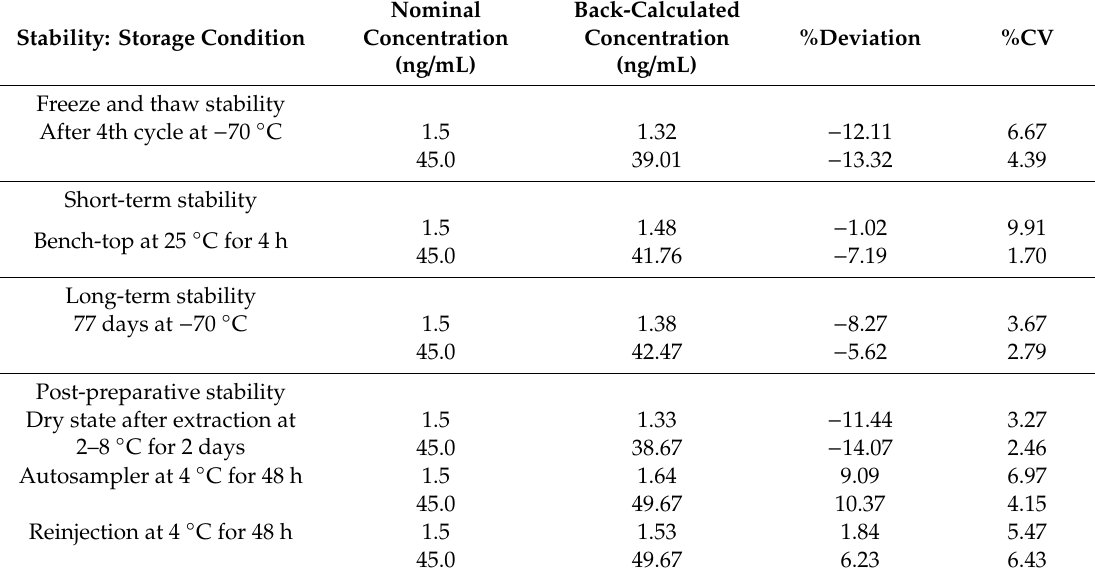
Table 5. Stability results of sumatriptan in human plasma ( n =